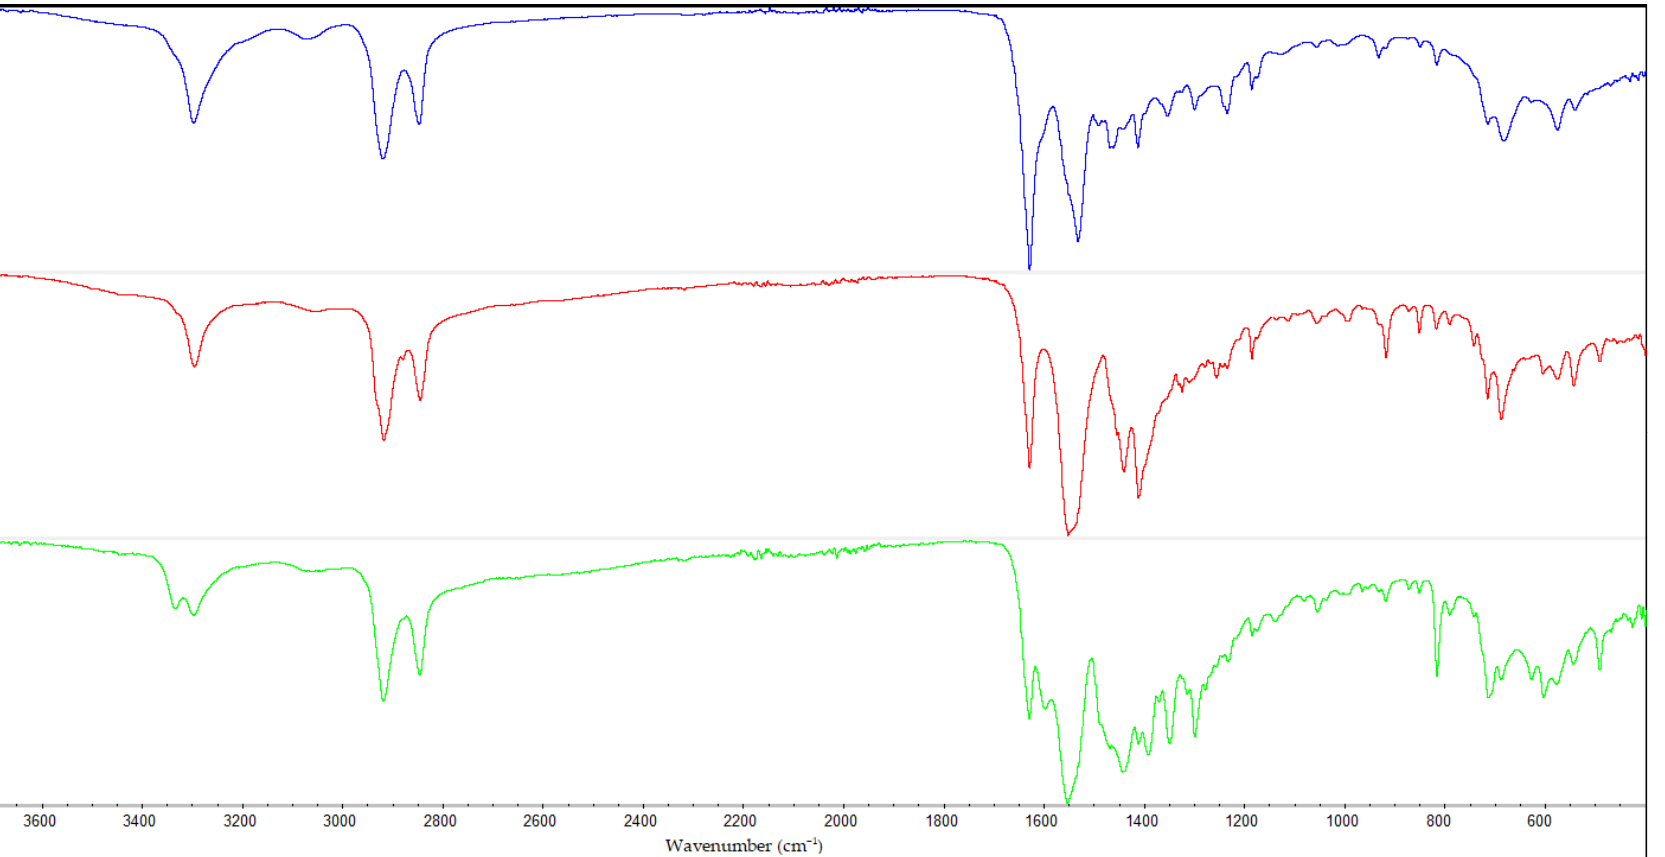
Figure 14. FTIR Spectra for Nylon 610 Nanocomposites with 1.5 wt% Graphite Nanosheets Treated at All Temperatures.